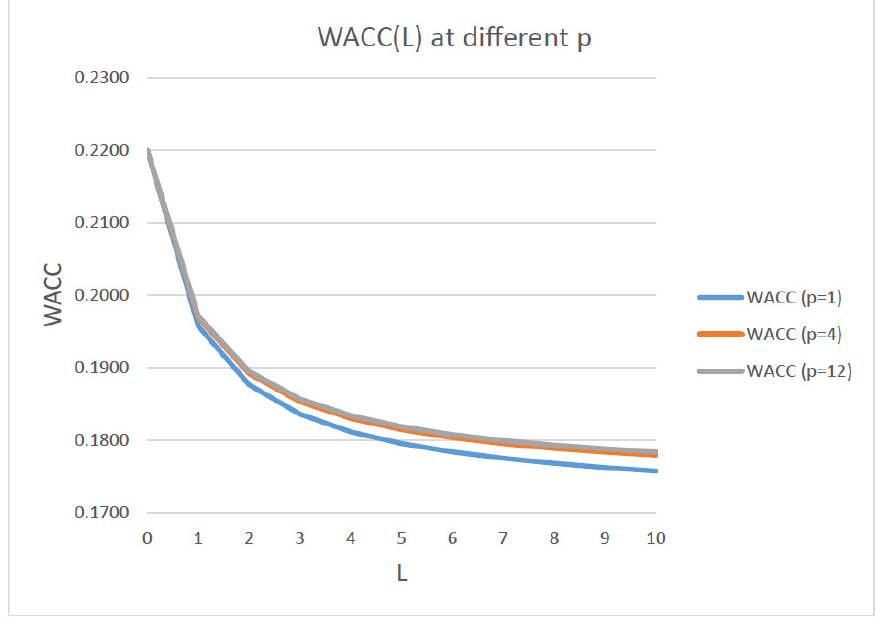
Figure 4. Change of the weighted average cost of capital, WACC, with leverage, L , for k d = 0.14, k 0 = 0.22, and p = 1, 4, and 12, for a 3-year project ( n = 3).